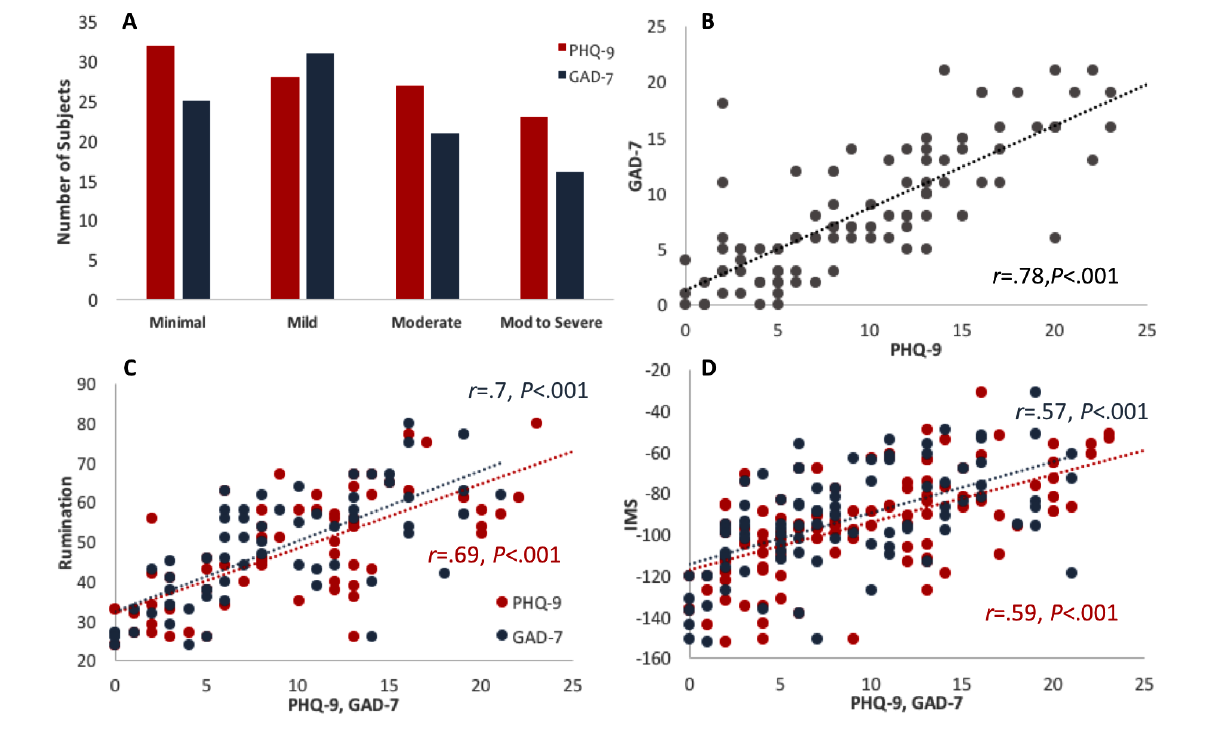
Figure 2. (A) PHQ-9 (red bars) and GAD-7 (blue bars) score distribution. Since the GAD-7 scale only has 4 categories and PHQ-9 has 5 categories, we have included PHQ-9 scores of moderately severe to severe in the “Mod to Severe” category. (B) PHQ-9 individual score correlation with the GAD-7 scale. (C) Correlation between PHQ-9 (red) and GAD-7 (blue) scales and the rumination scale. (D) Correlation between PHQ-9 (red) and GAD-7